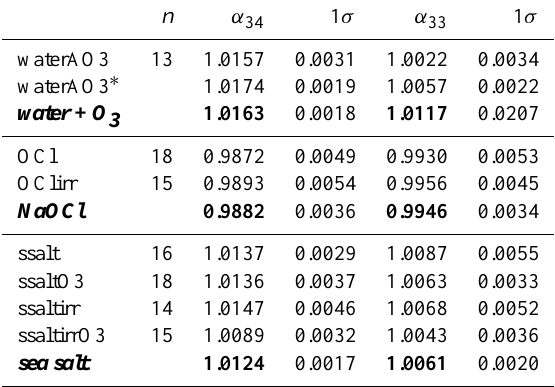
Table 4. Fractionation factors for the uptake and oxidation of SO 2 by droplets of pure water, sea salt aerosol and NaOCl aerosol (ab- breviations are defined in Table 1). Values in bold are the averages for a particular aerosol type; for the oxidation of SO 2 in pure water aerosol by O 3 , the present value is averaged with previous measure- ments. ∗ from Harris et al. (2012b). n is the number of measurements and 1 σ is the error of the